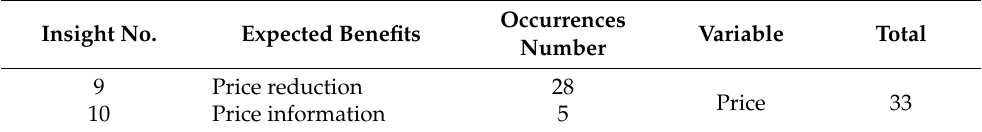
Table 6. Subgroup of comments classified into the price